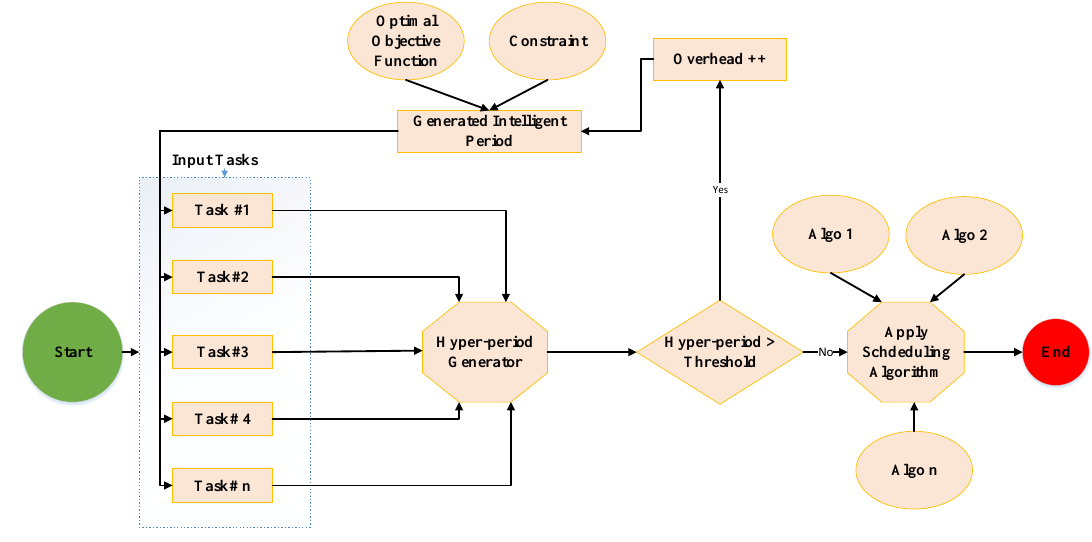
Figure 3. Working flow diagram of the Proposed